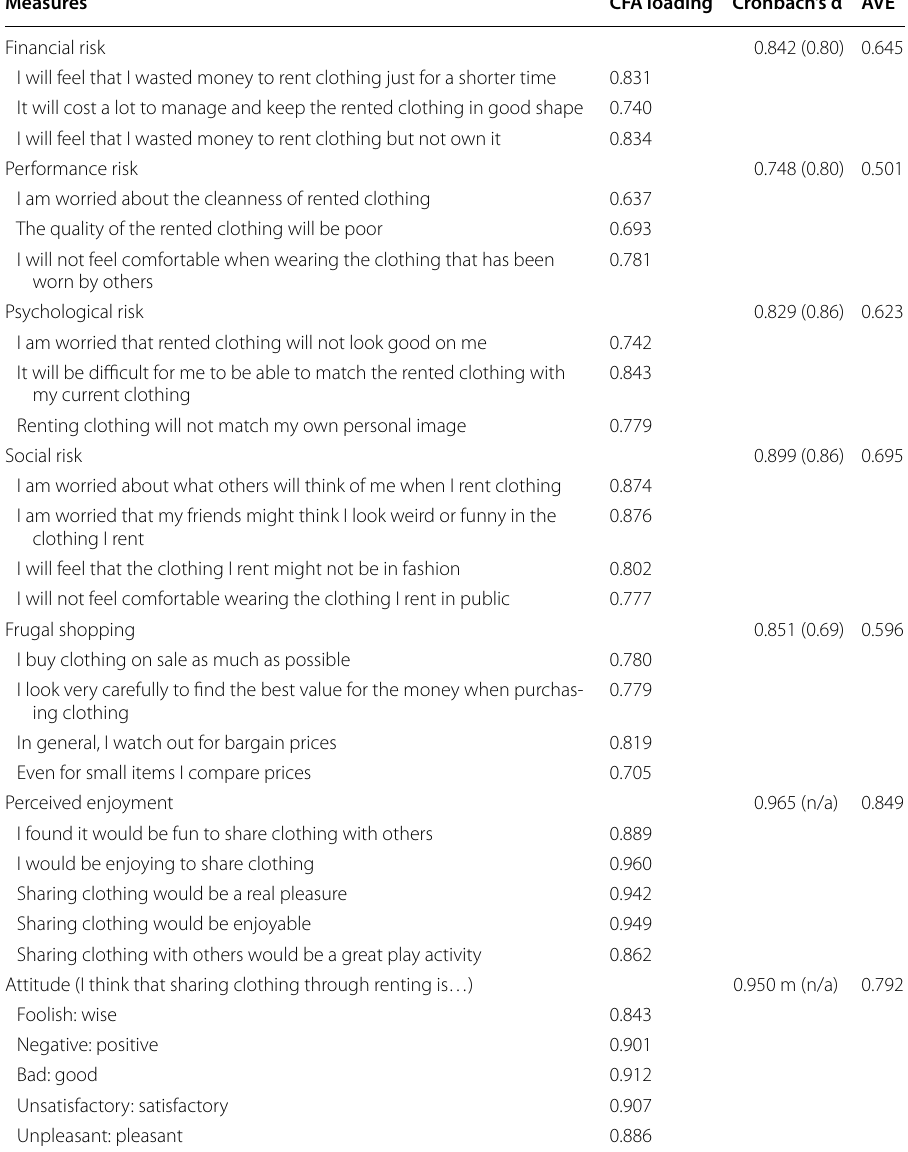
Table 2 Measurement model